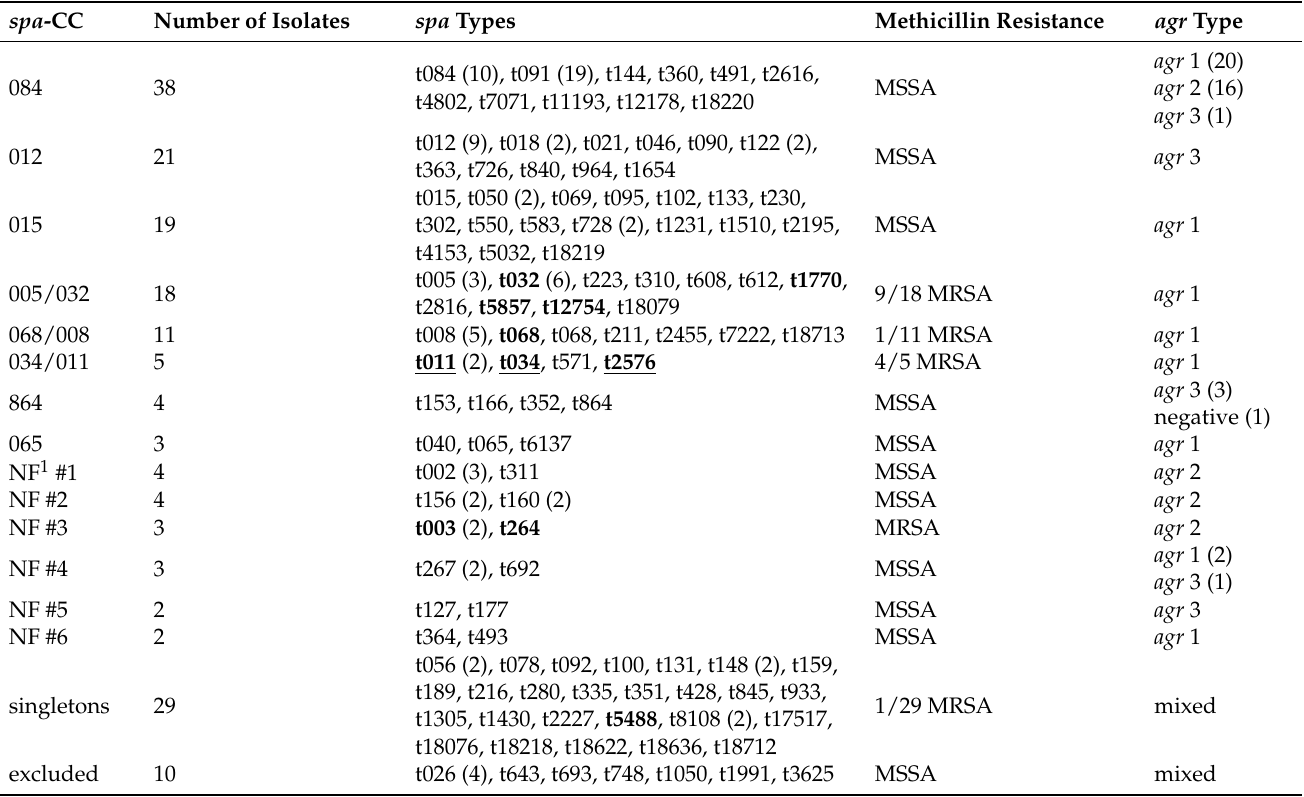
Table 4. Population structure as identified by spa typing, BURP analysis, mecA and agr